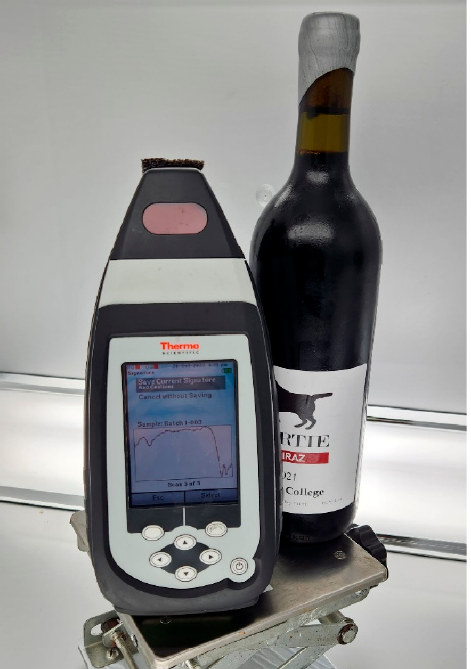
Figure 1. Near-infrared spectroscopy hand-held device, including the custom-made attachment to avoid external light, and sample of the Bertie Shiraz wine bottle from 2021 vintage.